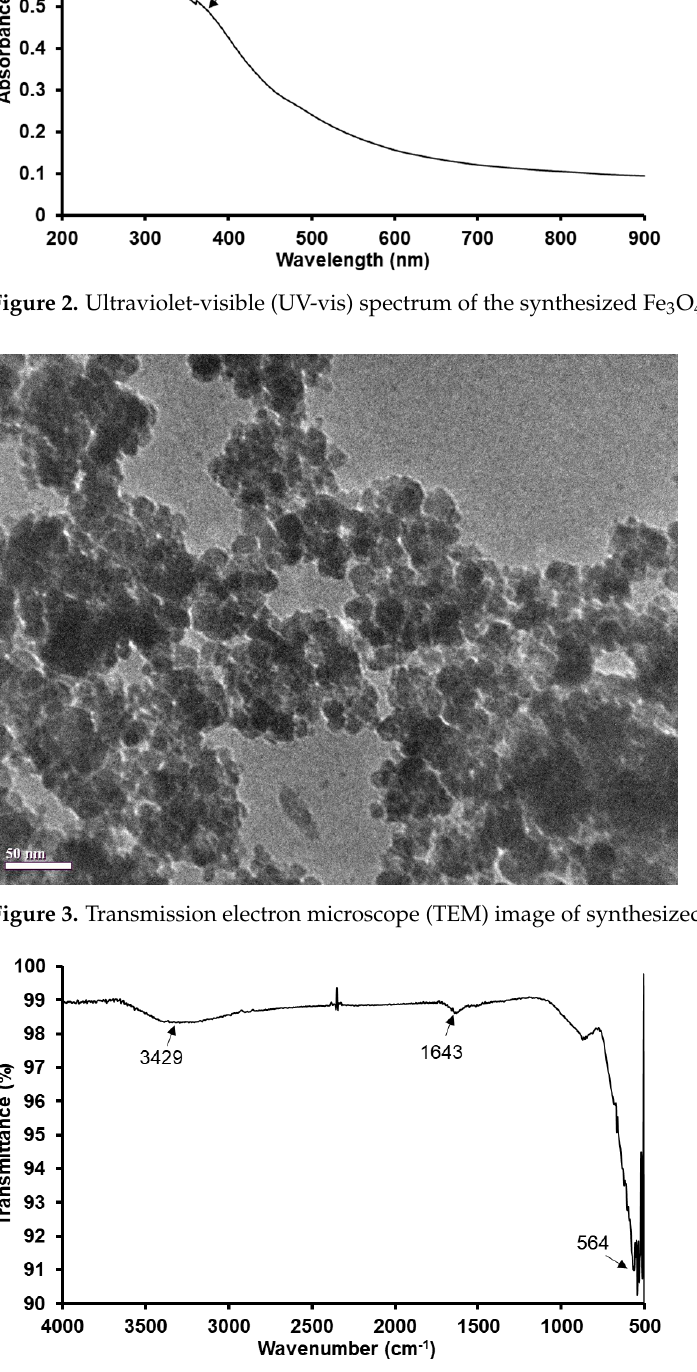
Figure 4. Fourier transform infrared spectroscopy (FTIR) spectra of synthesized Fe 3 O 4 nanoparticles. The XRD pattern of the synthesized Fe 3 O 4 nanoparticles is depicted in Figure 5. The peaks at 18.6°, 30.1°, 35.6°, 43°, 57.3°, 62.9°, and 74.3° represent the planes of Fe 3 O 4 at (111), (220), (311), (400), (511), (440), and (533), respectively, confirming its cubic spinel phase